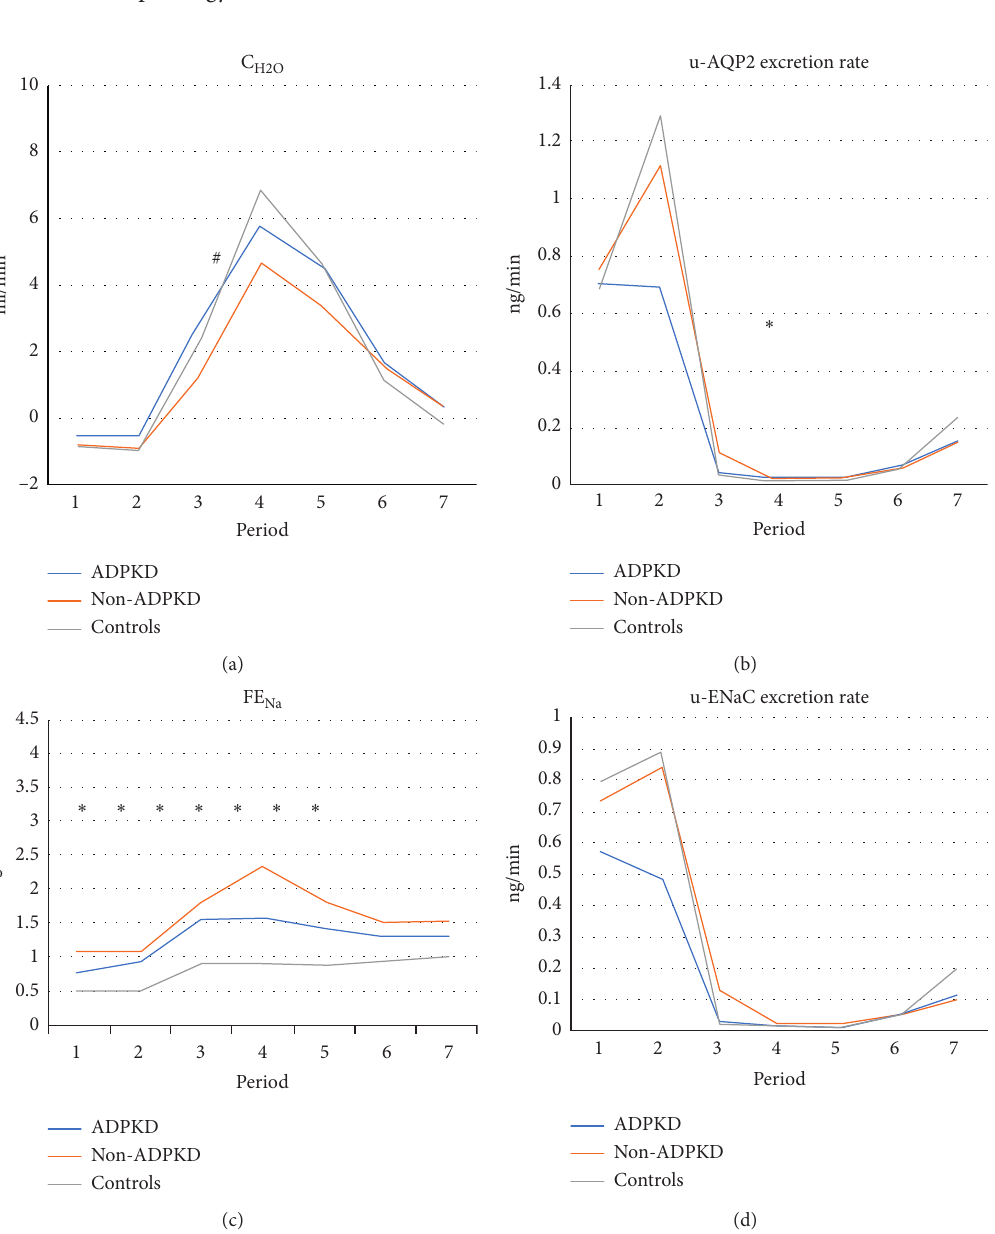
4.7. Systemic Haemodynamics. Systolic bBP, diastolic bBP, MAP, heart rate, systolic cBP, diastolic cBP, Aix, and PWV are presented in Table 5. Systolic bBP was higher at baseline (Period 2) in the two patient groups compared to healthy controls (129 ± 11 mm